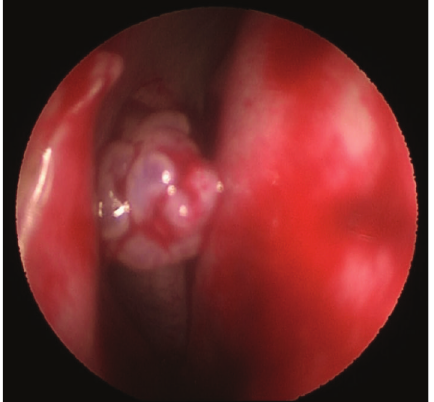
Figure 1: CT orbits: coronal section showing a well-defined hetero- geneous lesion protruding into the middle meatus and right orbit.